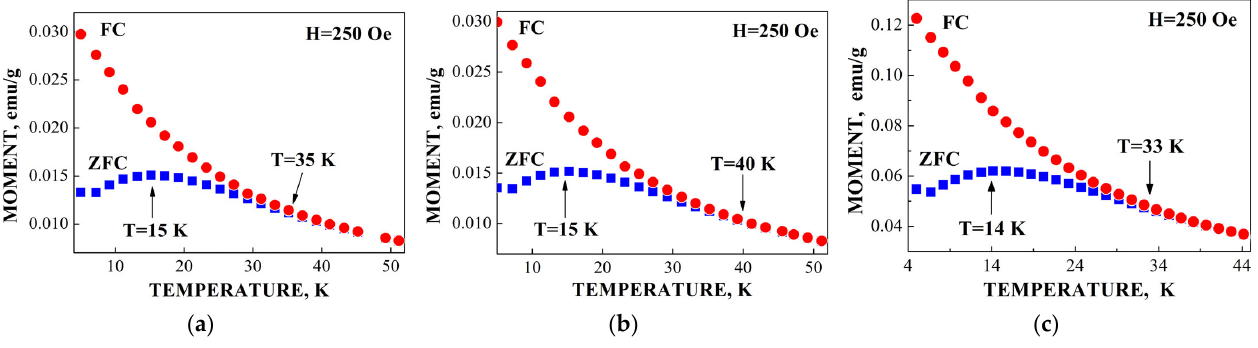
Figure 25. Zero ‐ field ‐ cooled (ZFC) and field ‐ cooled (FC) curves for the iron cores in Ferrum Lek ( a ), Maltofer ® ( b ) and Ferrifol ( c ). Indicated temperatures are the blocking temperatures T B for the largest iron cores (~35, ~40 and ~33 K) and the mean blocking temperatures (~15–14 K). Adapted from Ref. [50] with permission from Springer Nature: Hyperfine Interactions, “Unusual tempera ‐ ture dependencies of Mössbauer parameters of the nanosized iron cores in ferritin and its phar ‐ maceutical analogues”, Alenkina I.V., Kuzmann E., Felner I., Kis V.K., Oshtrakh M.I., ©2021.